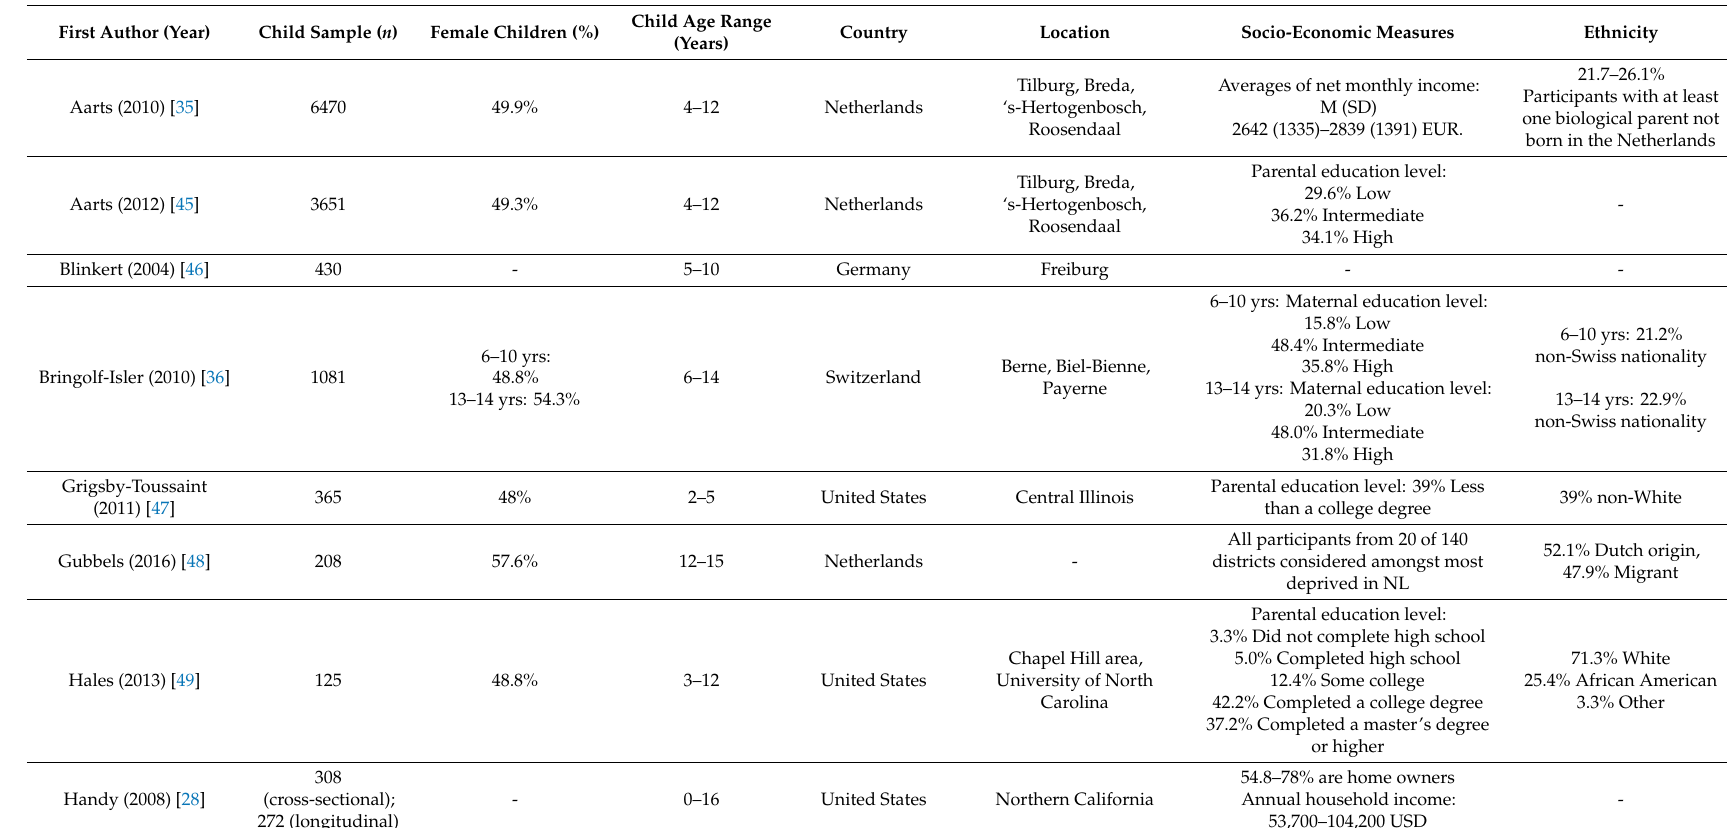
Table 1. Participant